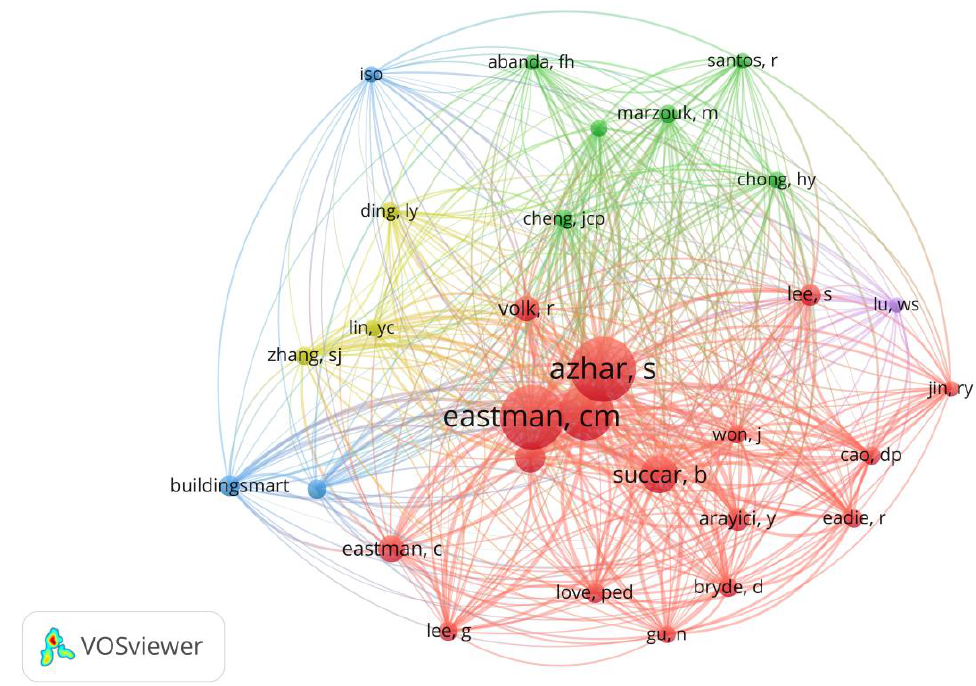
Figure 9. The network of author ’ s co-citation.